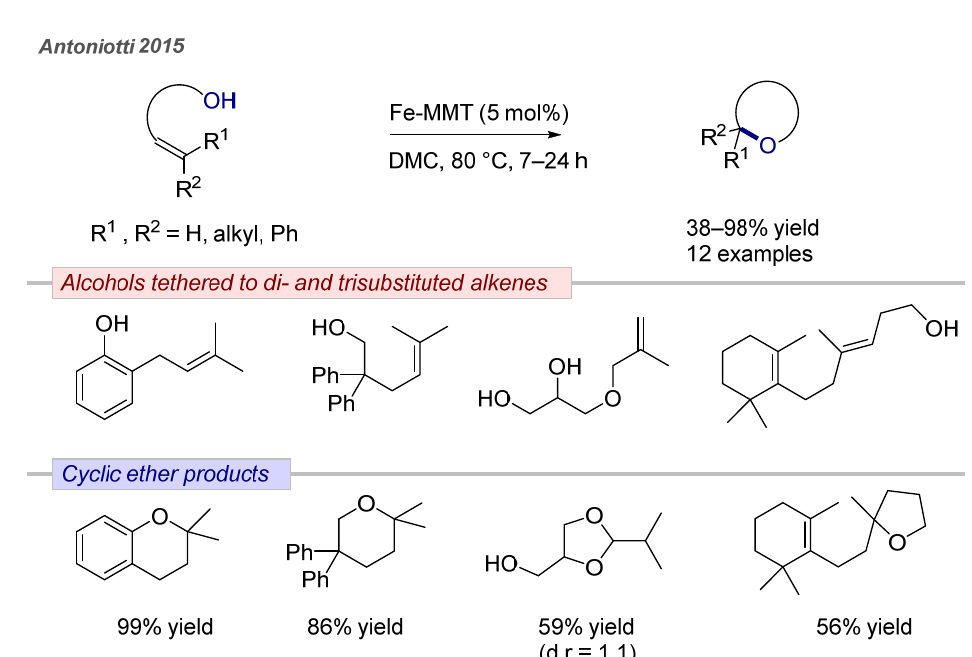
Figure 2. Cyclohydroalkoxylation of alkenes catalyzed by Fe-MMT. d.r = diastereomeric ratio.